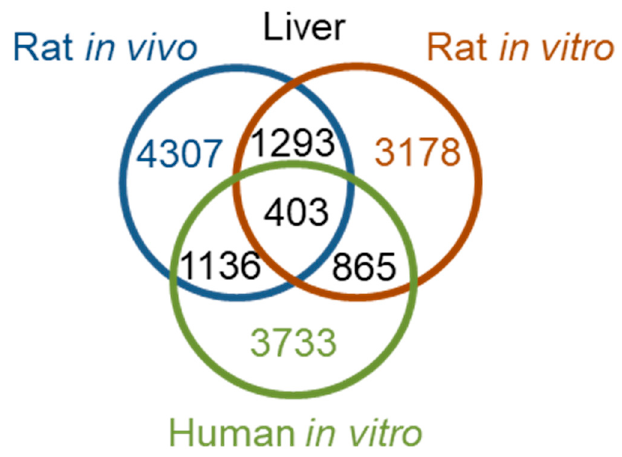
Figure 5. Overlap of differentially expressed genes (DEGs) 24 h after thioacetamide or thioacetamide- S-oxide treatment. Table 5. KEGG pathways enriched in overlapping DEGs.